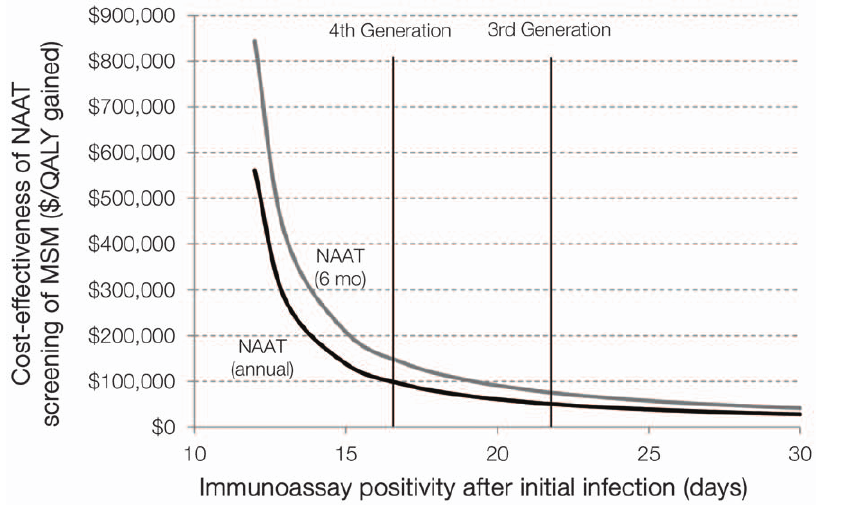
Figure 1. One-way sensitivity analysis on the window period of detection. The cost-effectiveness of NAAT testing of MSM, given variations in the window period of detection for the immunoassay. Testing occurs annually (black line) or every six months (grey line), and cost-effectiveness is relative to screening with immunoassay only. MSM = men who have sex with men; NAAT = nucleic acid amplification test; QALY = quality-adjusted life